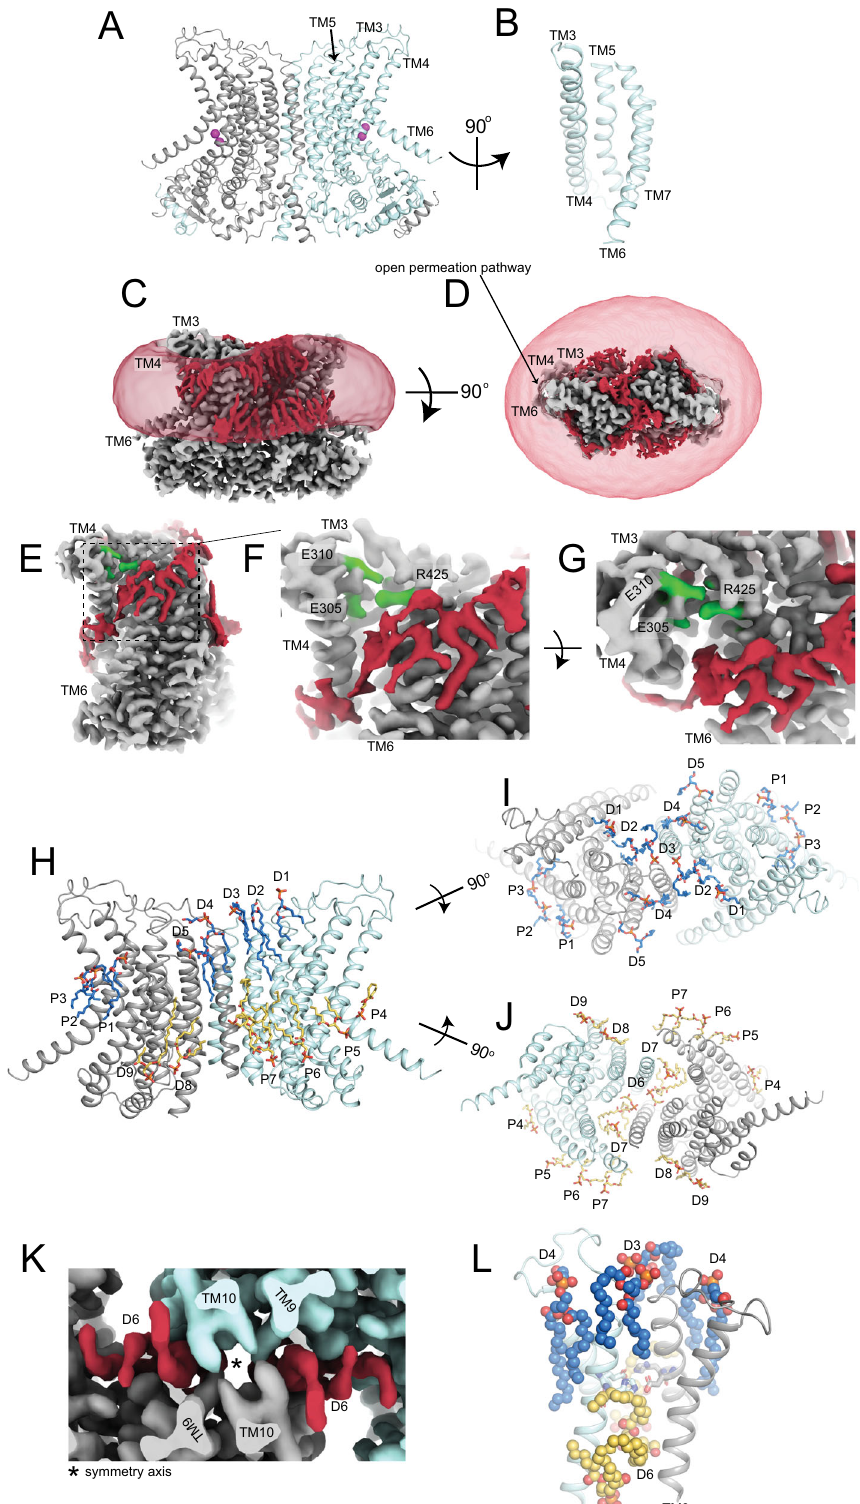
contact above the symmetry axis (Supplementary Fig. 2D). A second lipid, D4, is wedged between TM9 and TM10 with its head coordinated by polar and charged residues in the TM9 – 10 linker (N593, P598, T604 and R606; Supplementary Fig. 2D). On the intracellular side, the heads of D6 from each subunit make contact across the symmetry axis and are wedged between